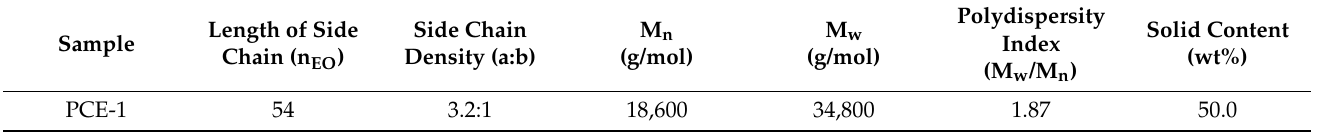
Figure 3. Molecular structure of the ether-based polycarboxylate (PCE) used in this study. Table 2. Characteristic molecular parameters of PCE-1.